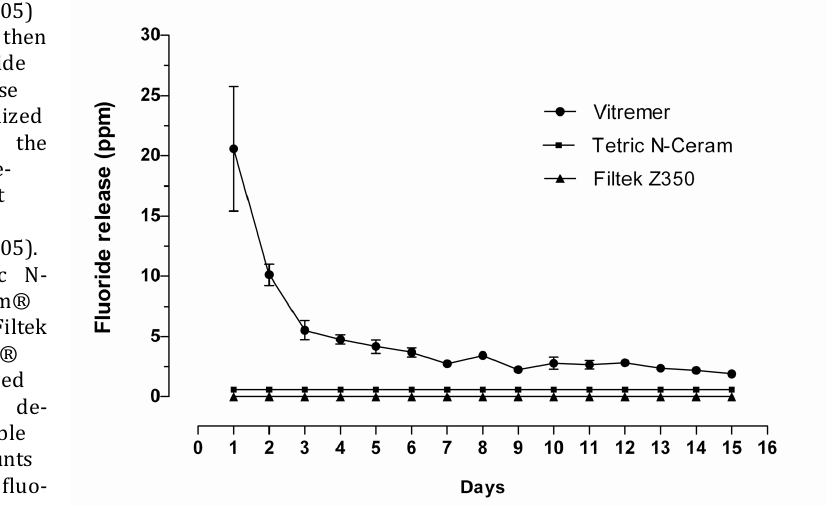
Figure 1. Release of 0luoride ions from the three materials at each day of the